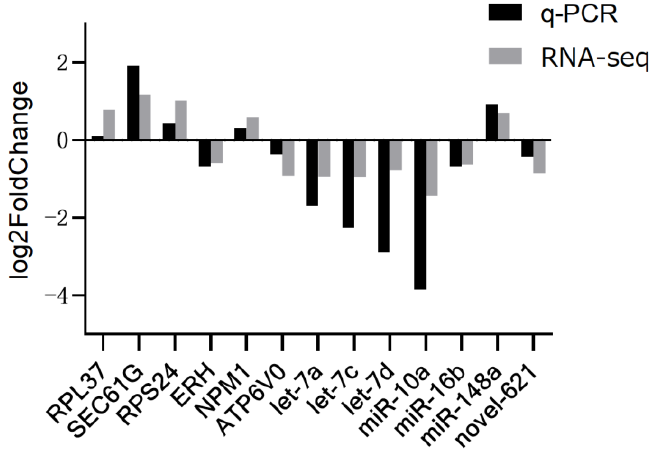
Figure 11. qPCR and RNA-seq quantitative analysis of differentially expressed genes and miRNA. As shown in Figure 11, the upregulation and downregulation trends verified by qPCR were precisely the same as those obtained from RNA-seq.